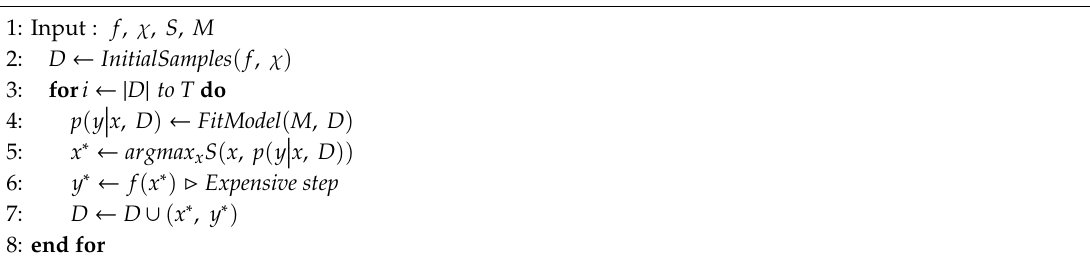
Algorithm 1 The pseudo-code of generic sequential model-based